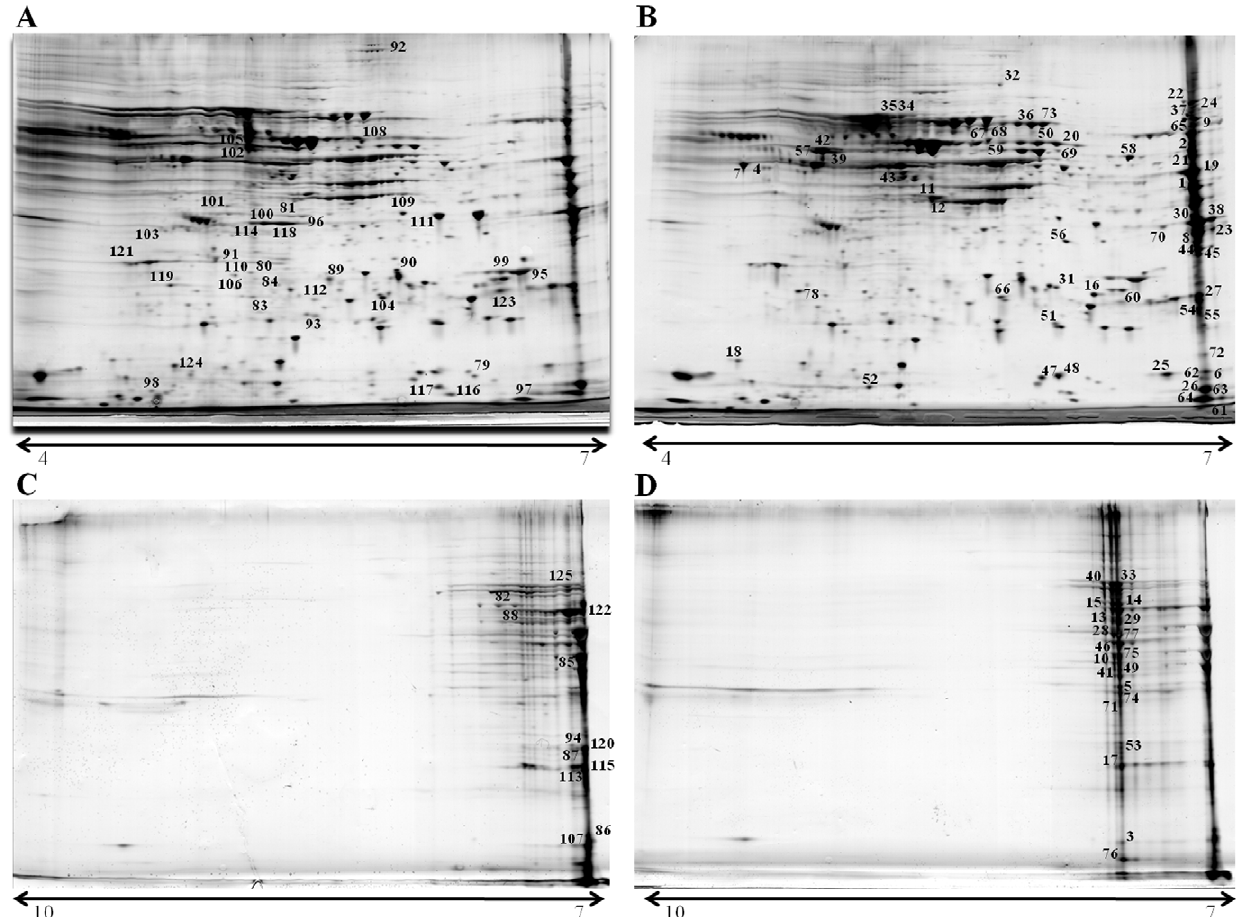
Figure 6. Two-dimensional proteomes of (A) non-infected Caco-2 cells (pI 4–7), (B) Caco-2 cells infected with C.concisus UNSWCD (pI 4–7), (C) non-infected Caco-2 cells (pI 7–10), and (D) Caco-2 cells infected with C.concisus UNSWCD (pI 7–10). Proteins differentially expressed between the two growth conditions are listed in Table 3 and Table 4. Spot numbers correspond to numbers in Table S1 and Table S2.